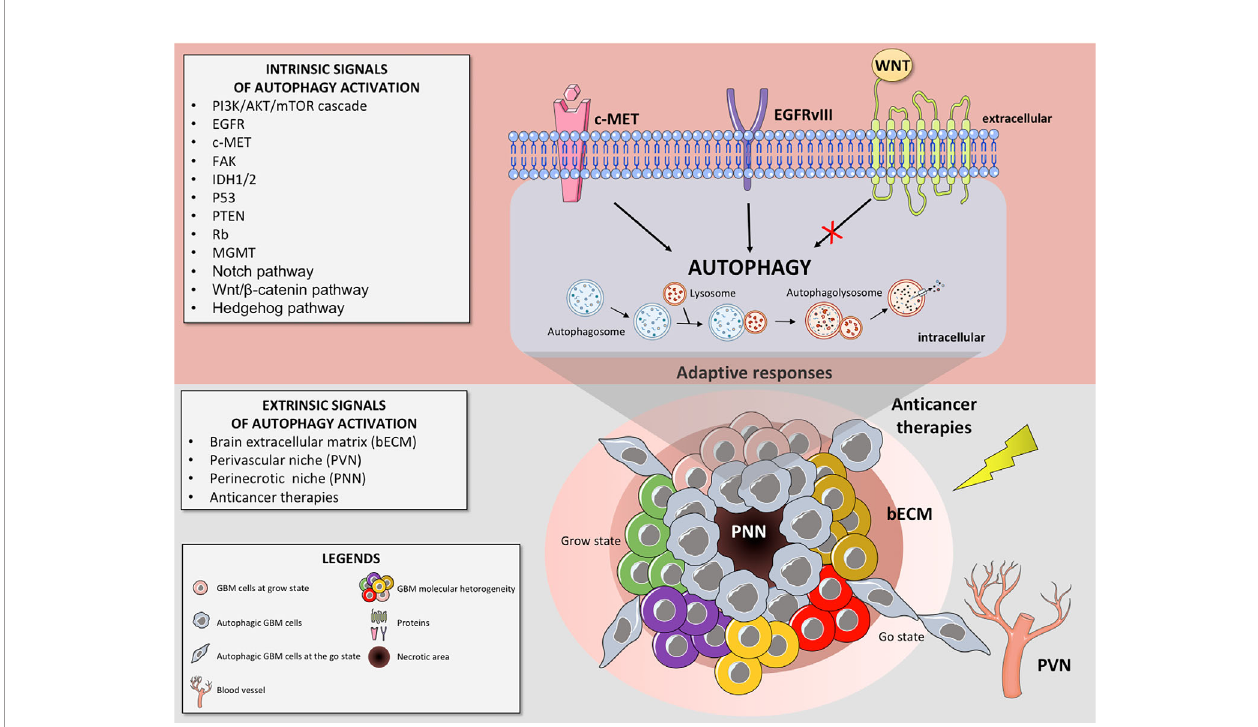
FIGURE 1 | Autophagy can be triggered by intrinsic and/or extrinsic GBM cells signals, contributing to tumor cell proliferation (grow state), invasion (go state) and resistance to therapies. Thus, autophagy may function as a mechanism of tumor cell survival and progression in a hostile microenvironment. The intrinsic signals activating autophagy in GBM consist of speci fi c gene expression levels alterations (like in the cMET gene), mutations (like the mutation in the EGFR gene that gives rise to the active mutant EGFRvIII) and/or speci fi c signaling pathways perturbations (such as in the Wnt pathway). The extrinsic signals associated with autophagy activation in GBM cells are: 1) the perinecrotic niches (PNN), composed by highly proliferative GBM cells and where the autophagy activation may function as a cellular adaptive response to hypoxia; 2) the perivascular niche (PVN), where the vascular endothelial cells can interact with the GBM ones, inducing autophagy and a stemness phenotype of those tumor cells; 3) the brain extracellular matrix (bECM), whose components may regulate autophagy; and 4) the anticancer therapies, which can activate autophagy as a cytoprotective